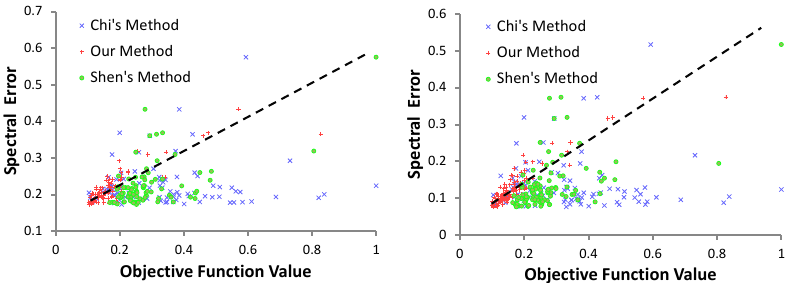
Figure 8. Relationship between spectral estimated error and objective function value of previous methods and our method on “natural” ( left ) and “paper” ( right ) dataset in [47]. Note the scatters of our method distribute along the black dashed line while the scatters of the previous method distribute irregularly.